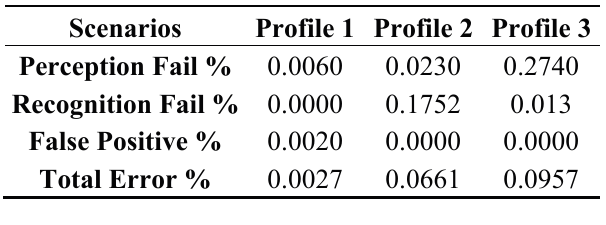
Table 6. Table of accumulated errors.